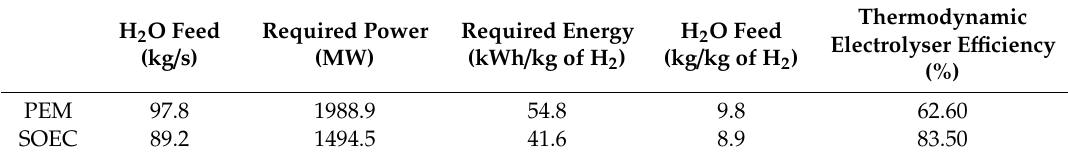
Table 5. Hydrogen production results based on PEM and SOEC models.